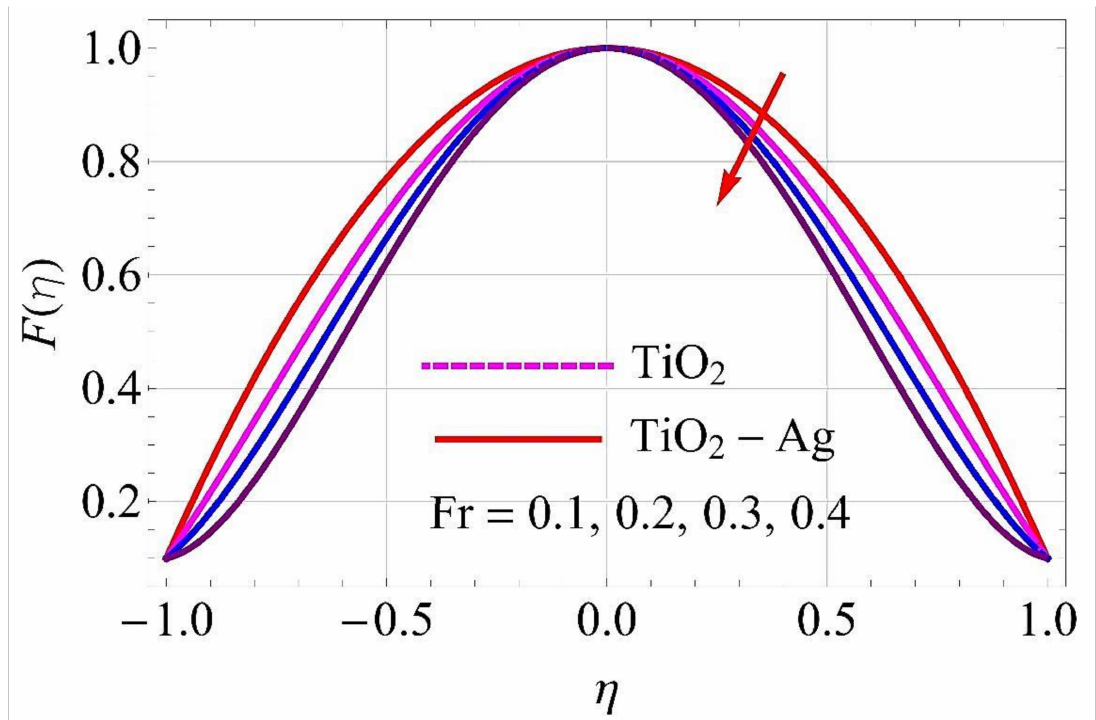
Figure 9. Velocity versus Fr with α = − 5 ◦ for converging/stretching circumstances. When Re = 25, φ 1 = φ 2 = 0.01, Rd = 0.4, Ec = Q = Ha = k ∗ = K 1 = 0.1.